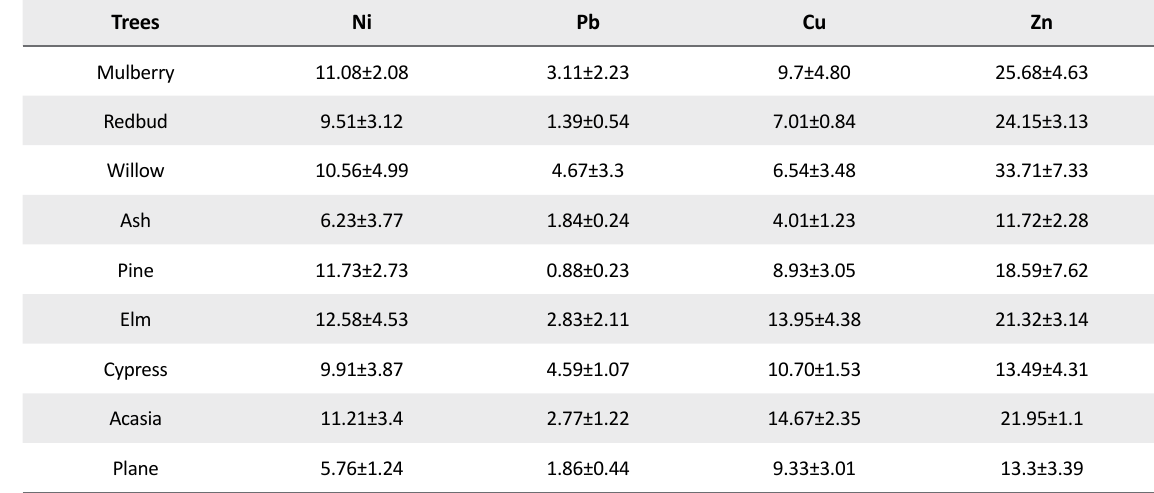
Table 6. Mean and standard deviation of metal concentrations in the leaves of different tree species (mg/kg)